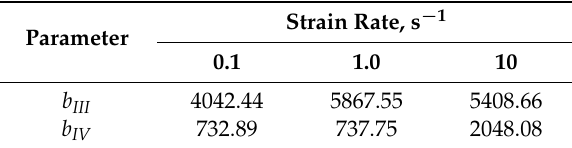
Table 3. Intercept values for stage III and IV